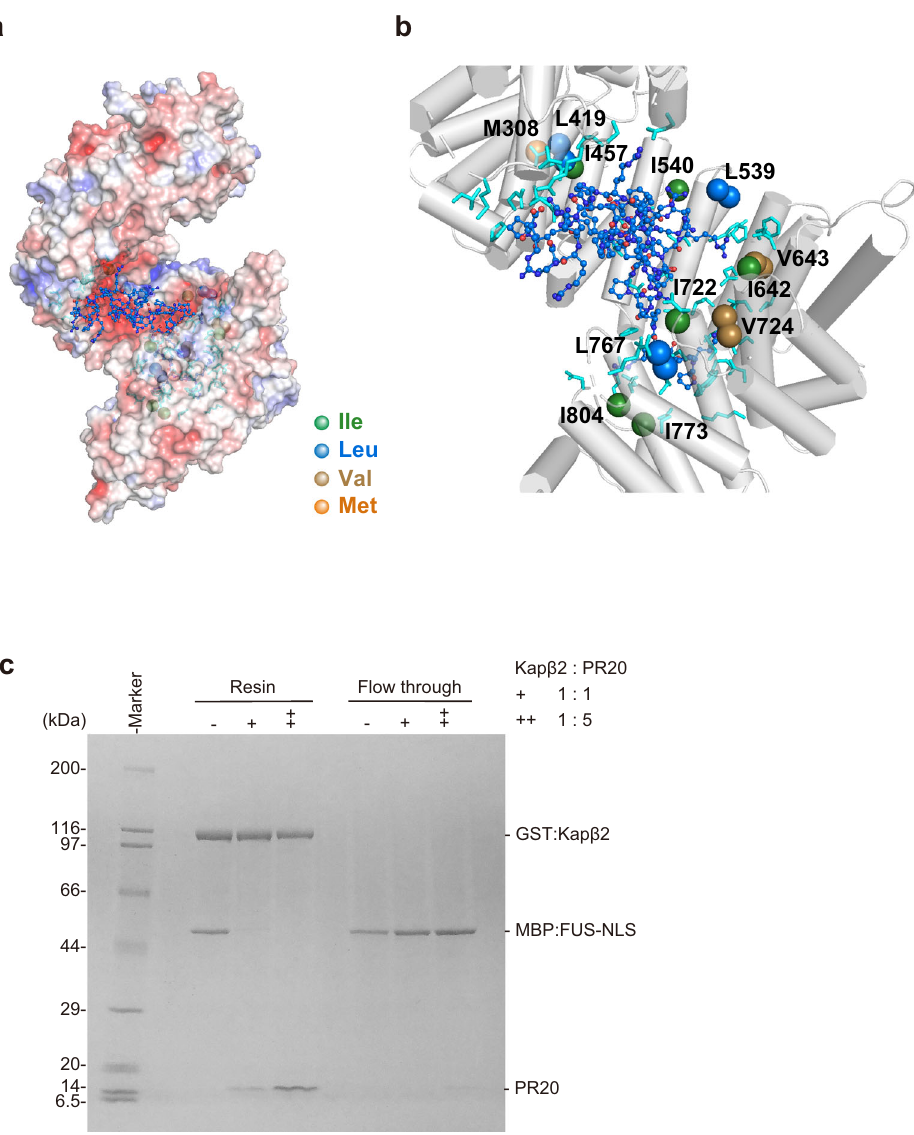
Fig. 5 The model of interaction between PR poly-dipeptides and Kap β 2. a Electrostatic potential of Kap β 2 and MD calculated model of PR poly-dipeptide inside of Kap β 2 cavity are shown. Blue and red colors show the positively charged and negatively charged regions, respectively. PR poly-dipeptide is colored blue. b Close-up view of Kap β 2 cavity. Methyl groups located close to the Kap β 2 cavity, isoleucine, leucine, valine, and methionine, are represented as spheres colored green, blue, yellow, and orange, respectively. Amino acids within 5 Å around the PR poly-dipeptide are colored cyan. c Pull-down binding assay showing the competition of PR20 and NLS of FUS to GST:Kap β 2. The experiment was independently repeated twice with similar results. Source data are provided as a Source Data fi